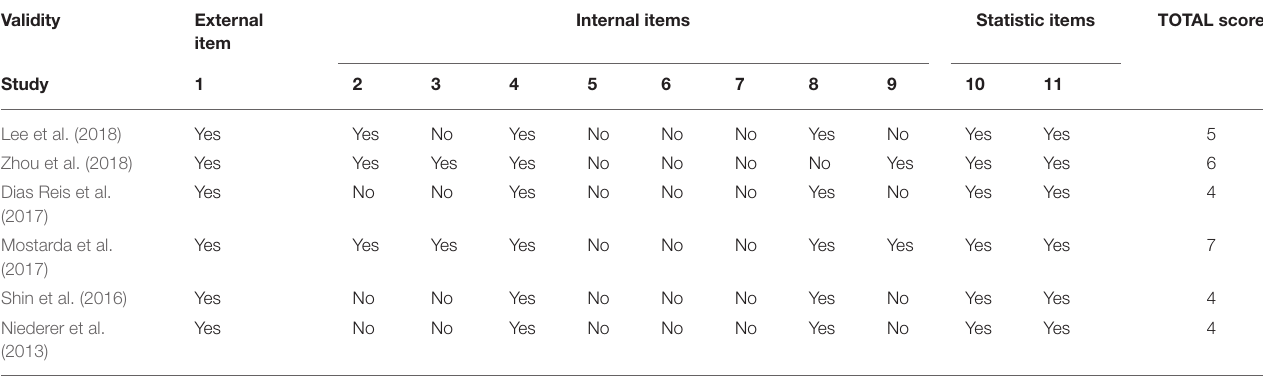
TABLE 1 | Risk of bias using the PEDro